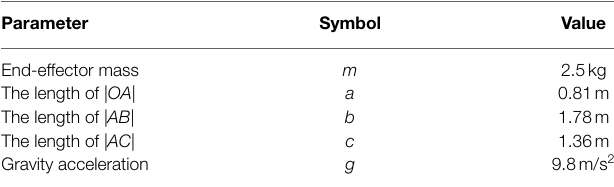
TABLE 1 | Parameters of the designed wire-driven rehabilitation